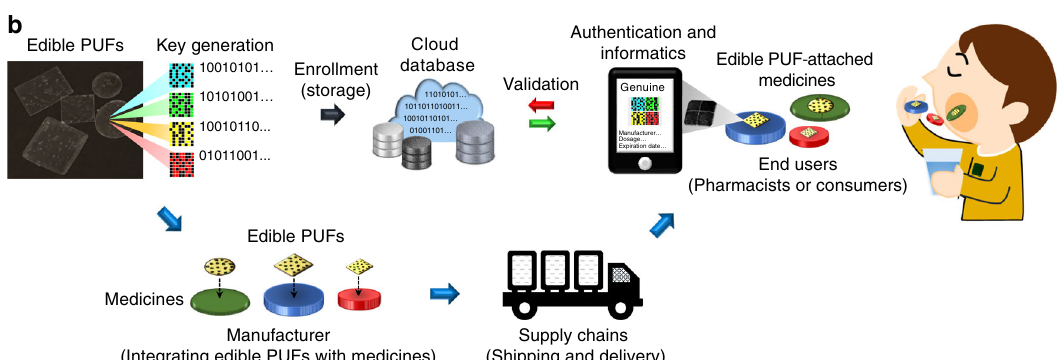
Fig. 1 Combination of PUF and on-dose authentication for anti-counterfeiting of medicines. a Schematic illustration of an on-dose PUF with a photograph of covert and transparent PUFs attached on the surface of medicines. The PUF device is composed of nothing but proteins from fl uorescent proteins and silk to be edible and digestible. The distinct photoluminescent properties of fl uorescent proteins in silk provide the parametric support of unique challenge- response pairs. In reaction to an input challenge ( C n ), the edible PUF generates its corresponding output response ( R n ), resulting in a cryptographic key ( K n ). The protein-based PUFs attached on the surface of medicines can be used for on-dose authentication of each individual medicine. b Concept of on- dose authentication. Each individual medicine in a solid oral dosage form (e.g., tablets and capsules) is integrated with an edible PUF device by the pharmaceutical manufacturer. End users (e.g., pharmacists and consumers) can ensure the provenance and validate the medicine by accessing the enrolled digital keys in a secure database (e.g., cloud server). In addition, this edible PUF could be utilized to provide dose information and manufacturer-determined data, including product information (e.g., dosage strength, dose frequency, and expiration date), manufacturing details (e.g., location, date, batch, and lot number), and distribution path (e.g., country, distributor, wholesaler, and